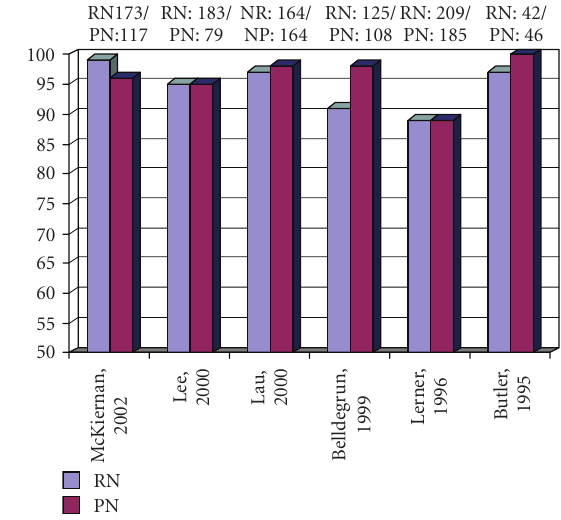
Figure 1: Five-year survival: radical nephrectomy (RN) versus partial nephrectomy